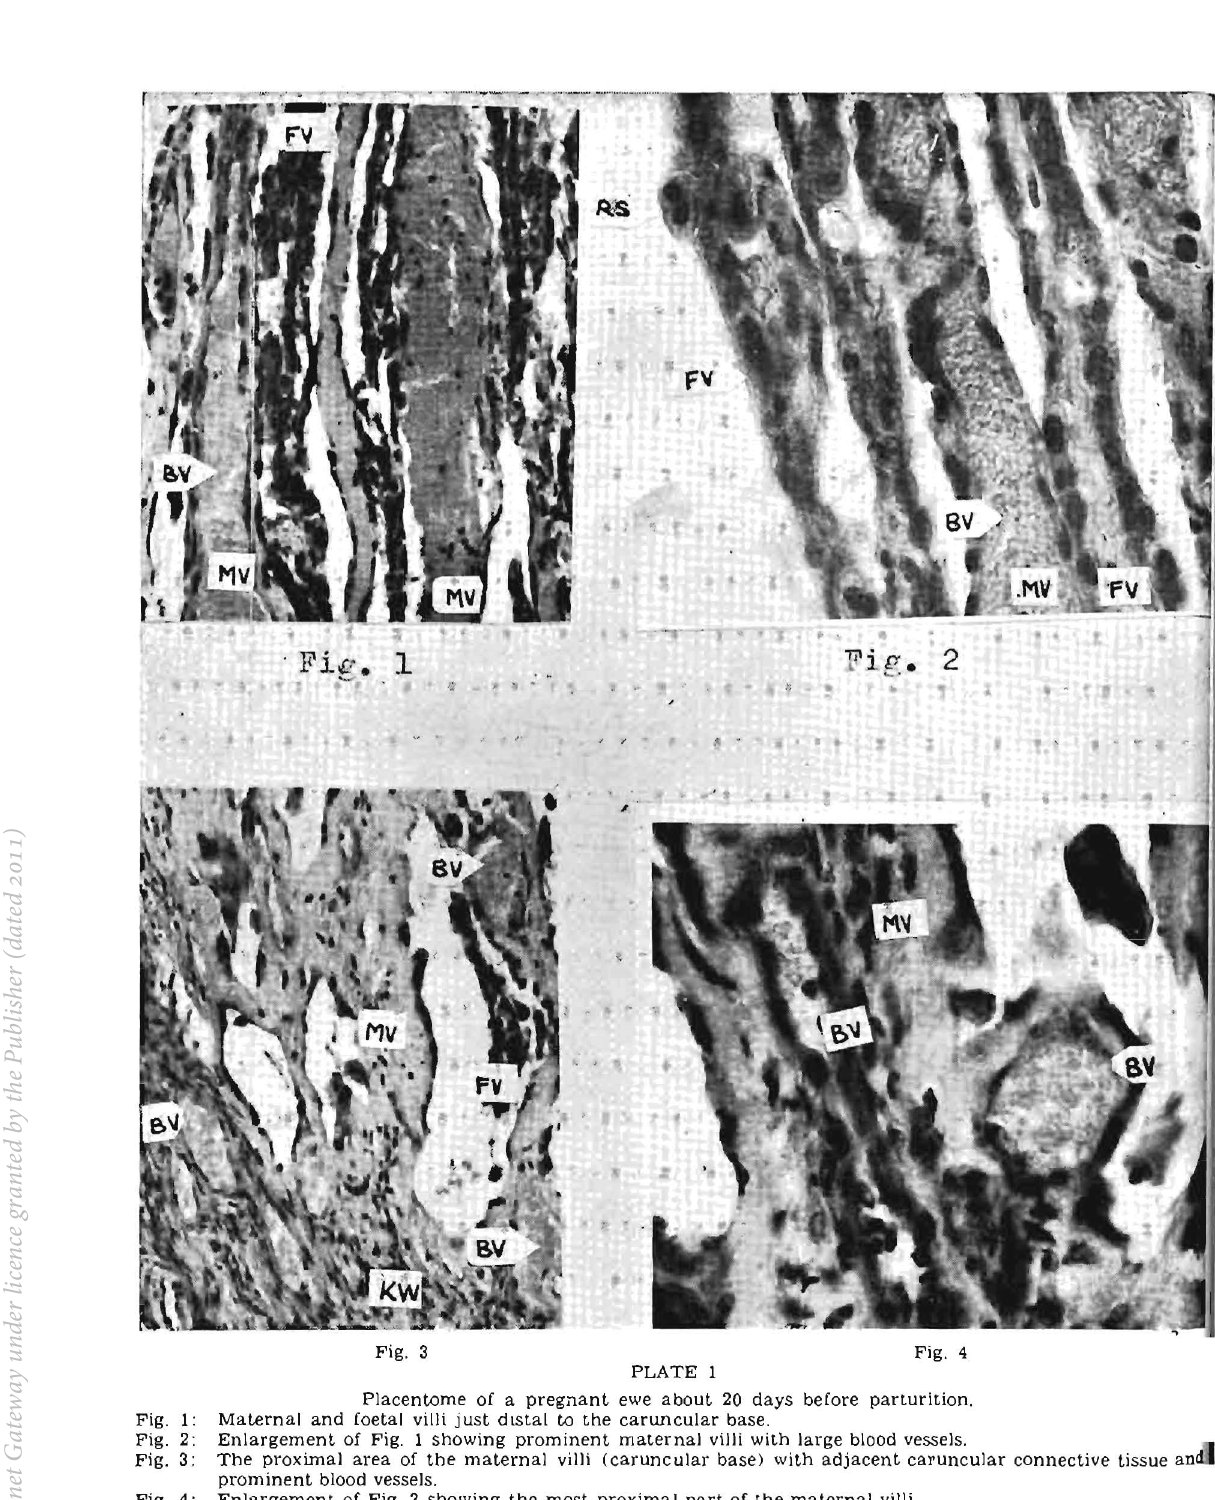
Placentome of a pregnant ewe about 20 days before parturition. Maternal and foetal villi just distal to the carWlcular